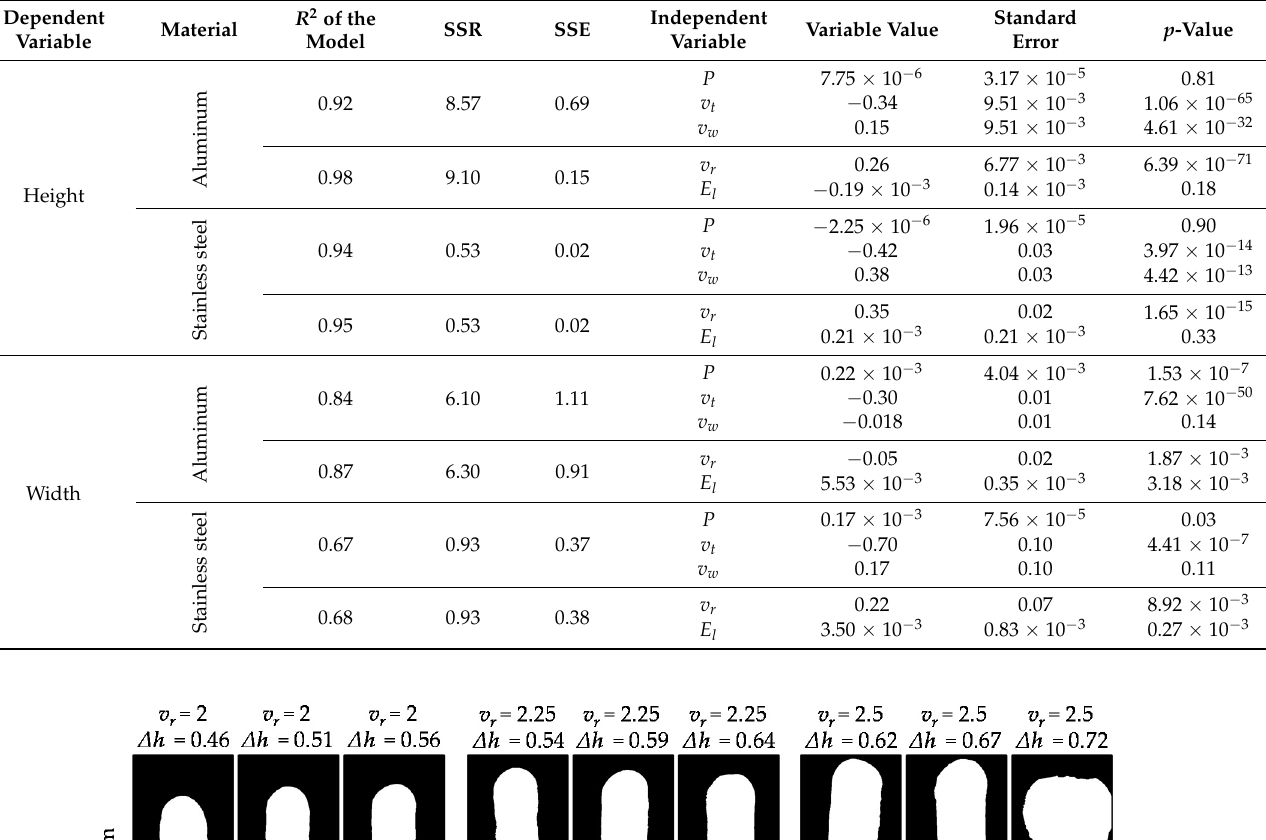
Table A1. Results of the ANOVA for the individual regression models.